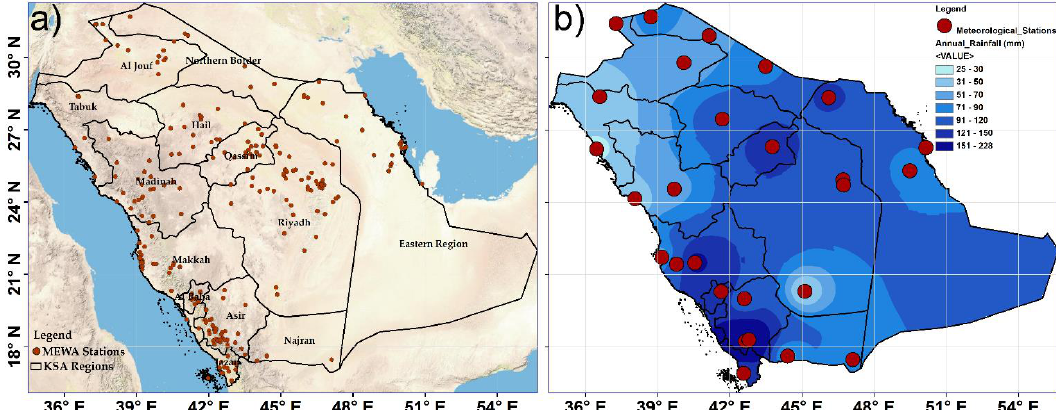
Figure 1. ( a ) Distribution of rain gauge network operated by Ministry of Environment, Water, and Agriculture (MEWA), Saudi Arabia; ( b ) Average annual rainfall values for rainfall stations distributed across Saudi Arabia from 1979 to 2009 [30].